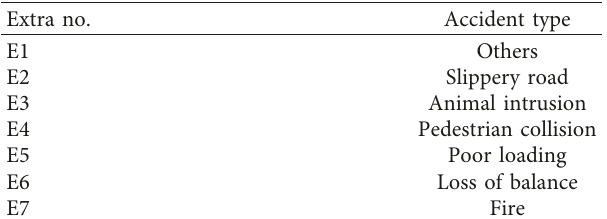
Table 4: Extra accident